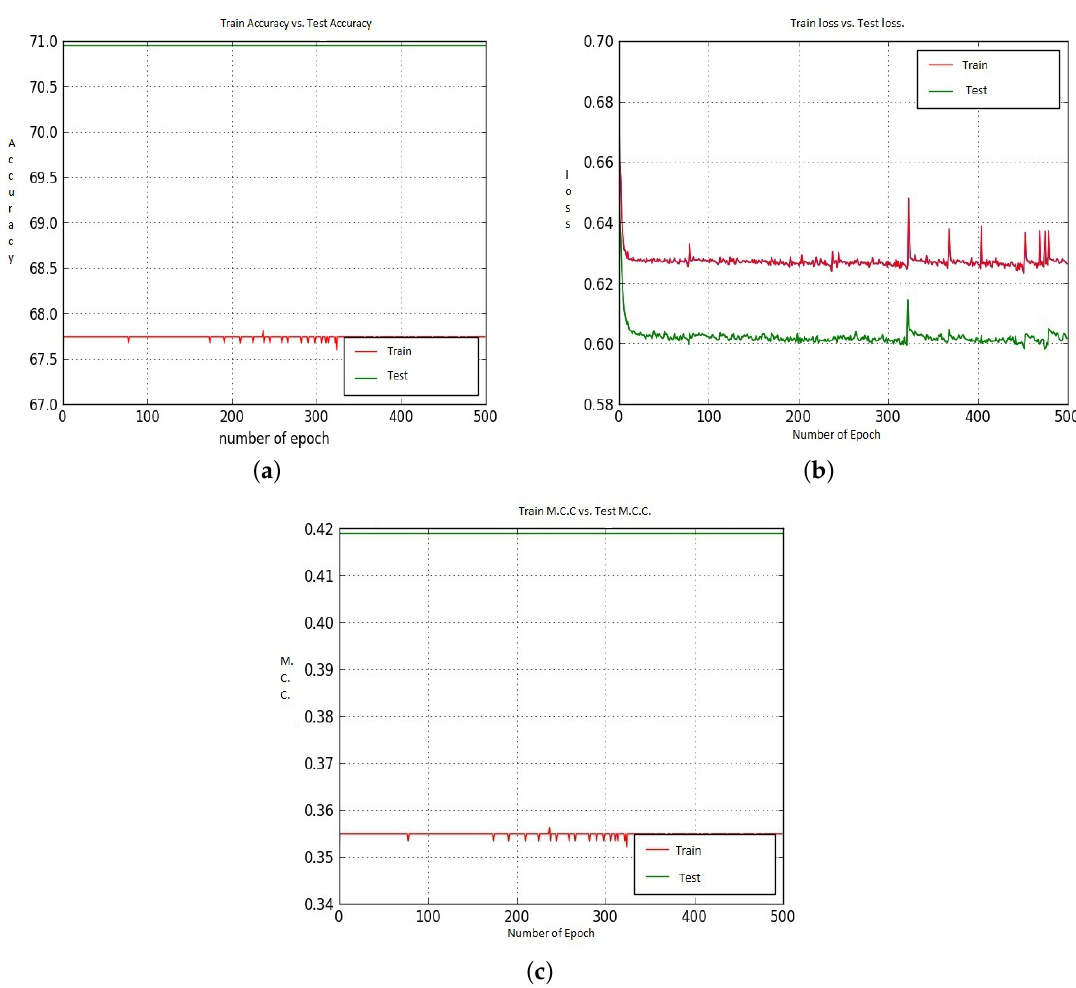
Figure 11. ( a – c ) represent the Train and Test Accuracy, Loss and M.C.C. values when we utilized Model-2, CNN-CH on the 40 ×